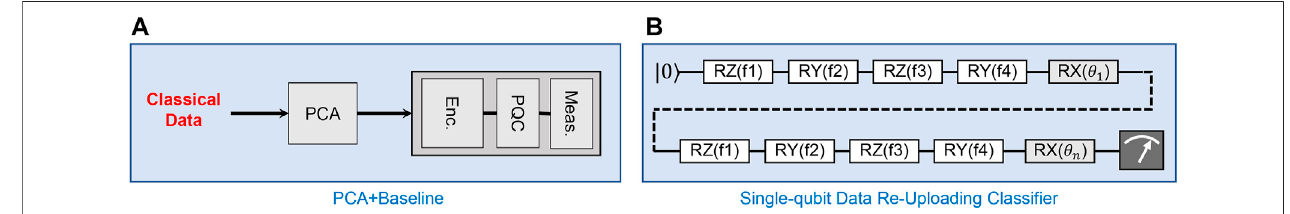
FIGURE 4 | Existing QNN models for small quantum computers. In (A) , the high dimensional data is transformed to a lower dimension using a classical algorithm (e.g., PCA, LDA, etc.). The lower-dimensional data is used as inputs to the Baseline QNN model [17, 23, 24]. In (B) , classical features are loaded repeatedly in a single- qubit using a series of rotation operations [25 –